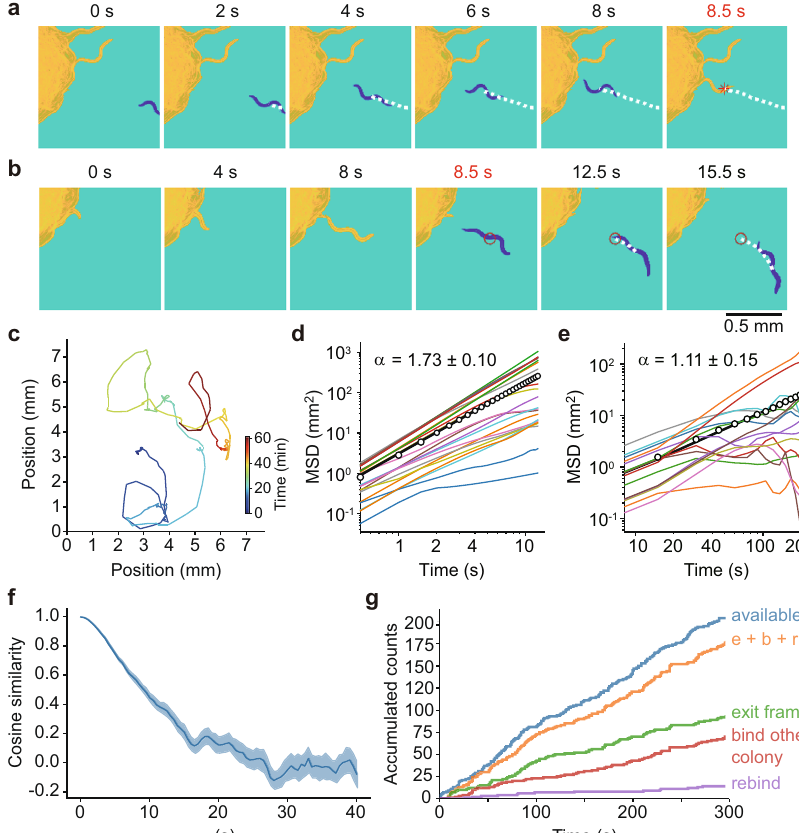
Fig. 2 C . elegans moves ballistically on second time scales and in a random walk fashion on longer time scales, and rarely returns to previous colonies. a A montage of a worm entering a colony. False coloring and marks were generated by an automatic tracking algorithm. Yellow: a portion of colony; blue: an out-of-colony worm; white dashed line: trajectory; red asterisk: algorithm-called entering event. b A montage of a worm exiting a colony. Coloring and labels are the same as in a . Red open circle: algorithm-called exiting event. c Sample trajectory of a single worm. d , e Mean squared displacement (MSD) vs. time interval for 15 individual worm trajectories, plotted on log – log plots. The data in the two panels are from separate independent experiments. The open circles represent ensemble MSDs for the binned data and the thick black lines are straight-line fi ts, which yielded values for α , the log – log slope, of 1.73 ± 0.10 ( r 2 > 0.9999), and 1.11 ± 0.15 ( r 2 = 0.9990), respectively. f Cosine similarity between the direction of C. elegans movement at times t ant t + τ , as a function of the value of τ . The blue center line indicates the median value across 432 traces from 4 independent experiments. The blue shaded area indicates the 95% con fi dence interval for the median value. g Ultimate fates of the worms that left colonies from eight imaging experiments. The cumulative total number of worms to have left a colony is designated “ available ” (blue). The other four colors represent the number of worms that rebound the same colony (purple), bound a different colony (red), exited the frame (green), or did any of these three things (e + b + r, orange). The number of worms that remained dispersed and still in frame is represented by the difference between the blue and orange